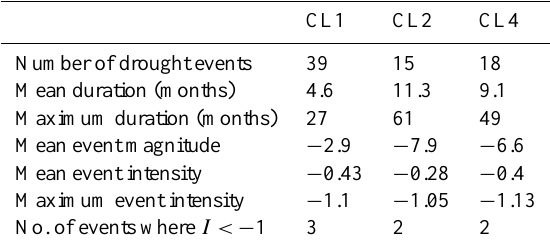
Table 2. Summary of drought event statistics for clusters C1,